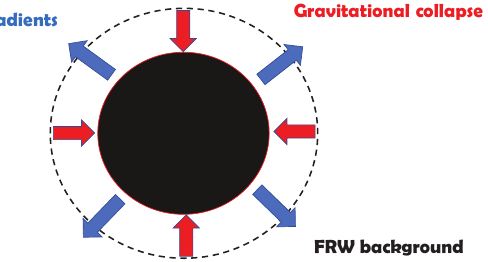
Figure 1. Schematic picture of the collapse/dispersion of a perturbation on an FLRW